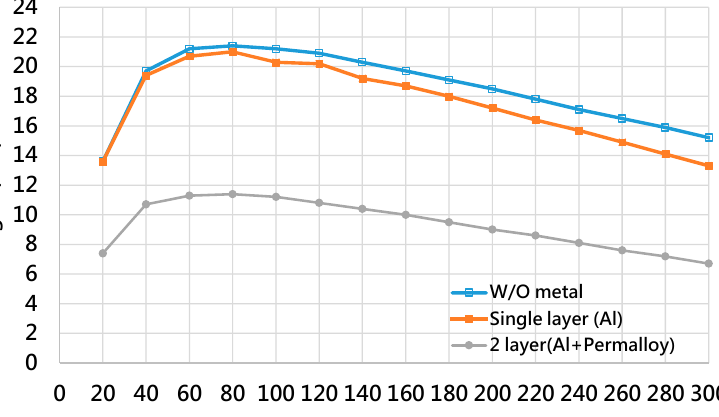
Figure 11. The magnetic strength of the multi-layer structure of the shielding box without holes. Table 10. The comparisons of shielding capability for the PMCS for the multi-layer structures with- out holes.